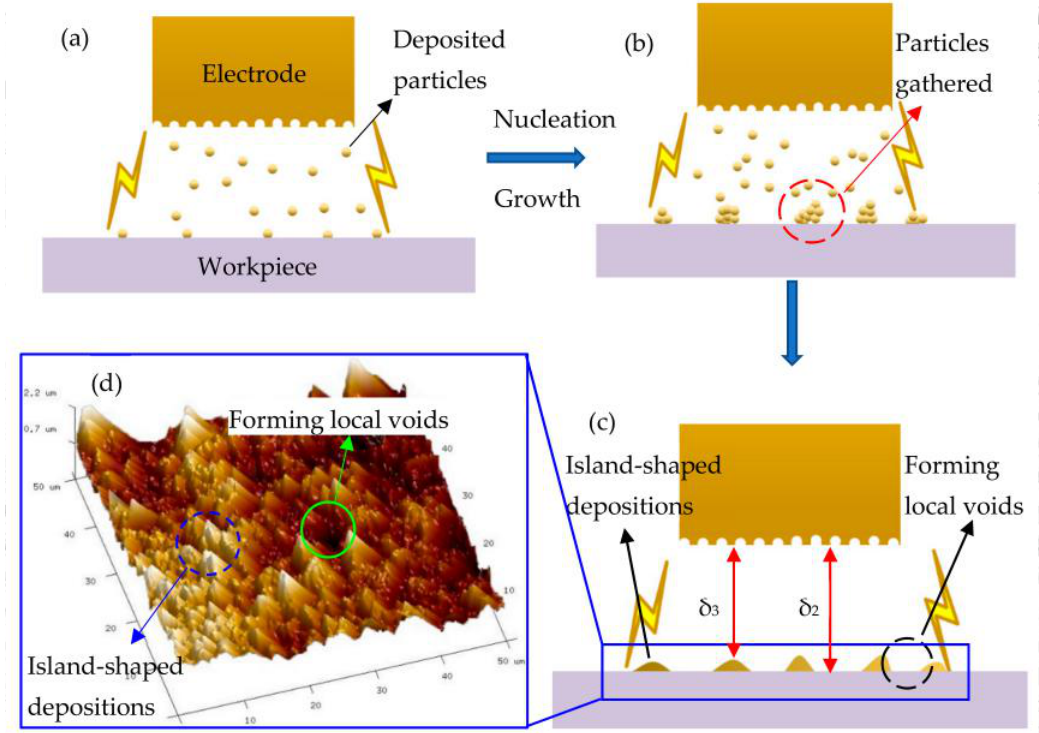
Figure 7. Schematic diagram of voids formation ( a ) particles randomly scatter, ( b ) particles gathered, ( c ) forming local voids, and ( d ) 3D-AFM image of